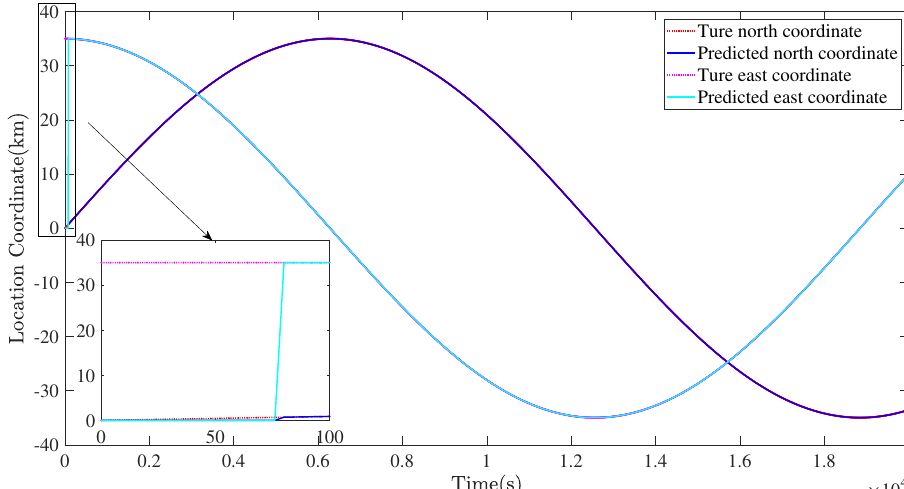
Figure 12. Prediction results of location information.